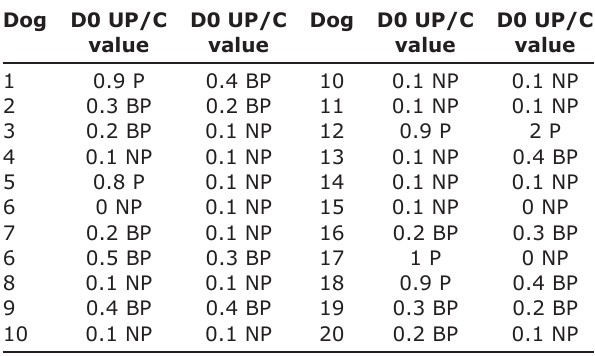
Table-2: UP/C value in 20 dogs before and after the treatment. Dog D0 UP/C